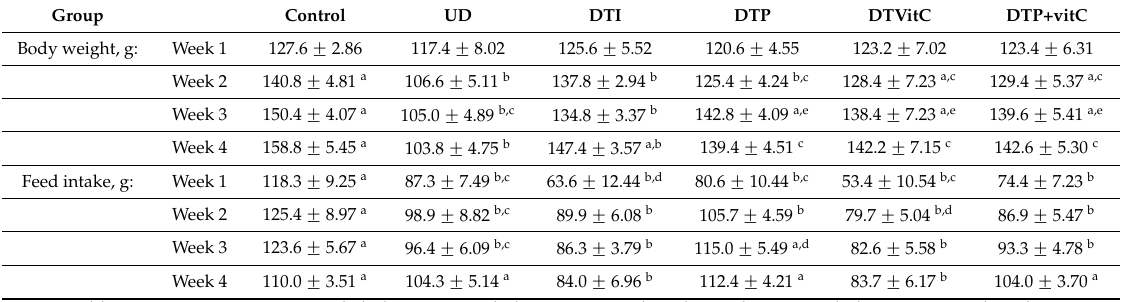
Table 5. Weekly body weights and feed intake of alloxan-induced diabetic rats treated with insulin, probiotic and vitamin